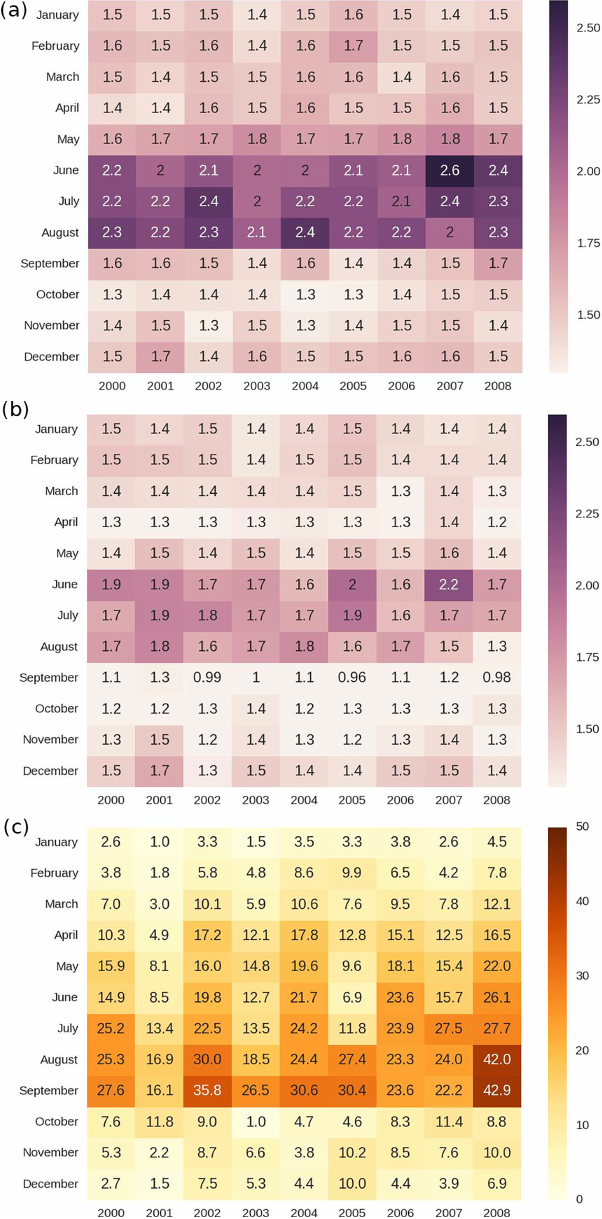
Figure 6. Sum of the sea ice area absolute differences (SoAD) com- pared to assimilated sea ice at every grid location, for every month (in 10 6 km 2 ), before assimilation (a) , after assimilation (b) and the percent difference between the two (c) . Positive differences corre- spond to a decrease of